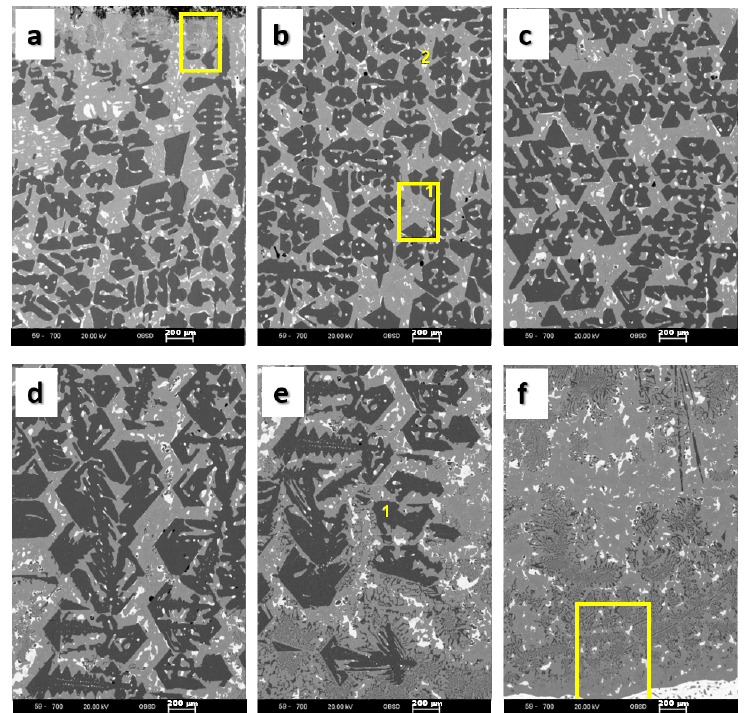
Figure 14. SEM images of the silicide product (subfigure ( a ) is from the phase boundary between silicide product and atmosphere, and subfigure ( f ) is from the phase boundary between silicide product and PbSn composite. Subfigures from ( b – e ) refers to the silicide product. The rectangles indicates the location of the partial sections seen in Figure